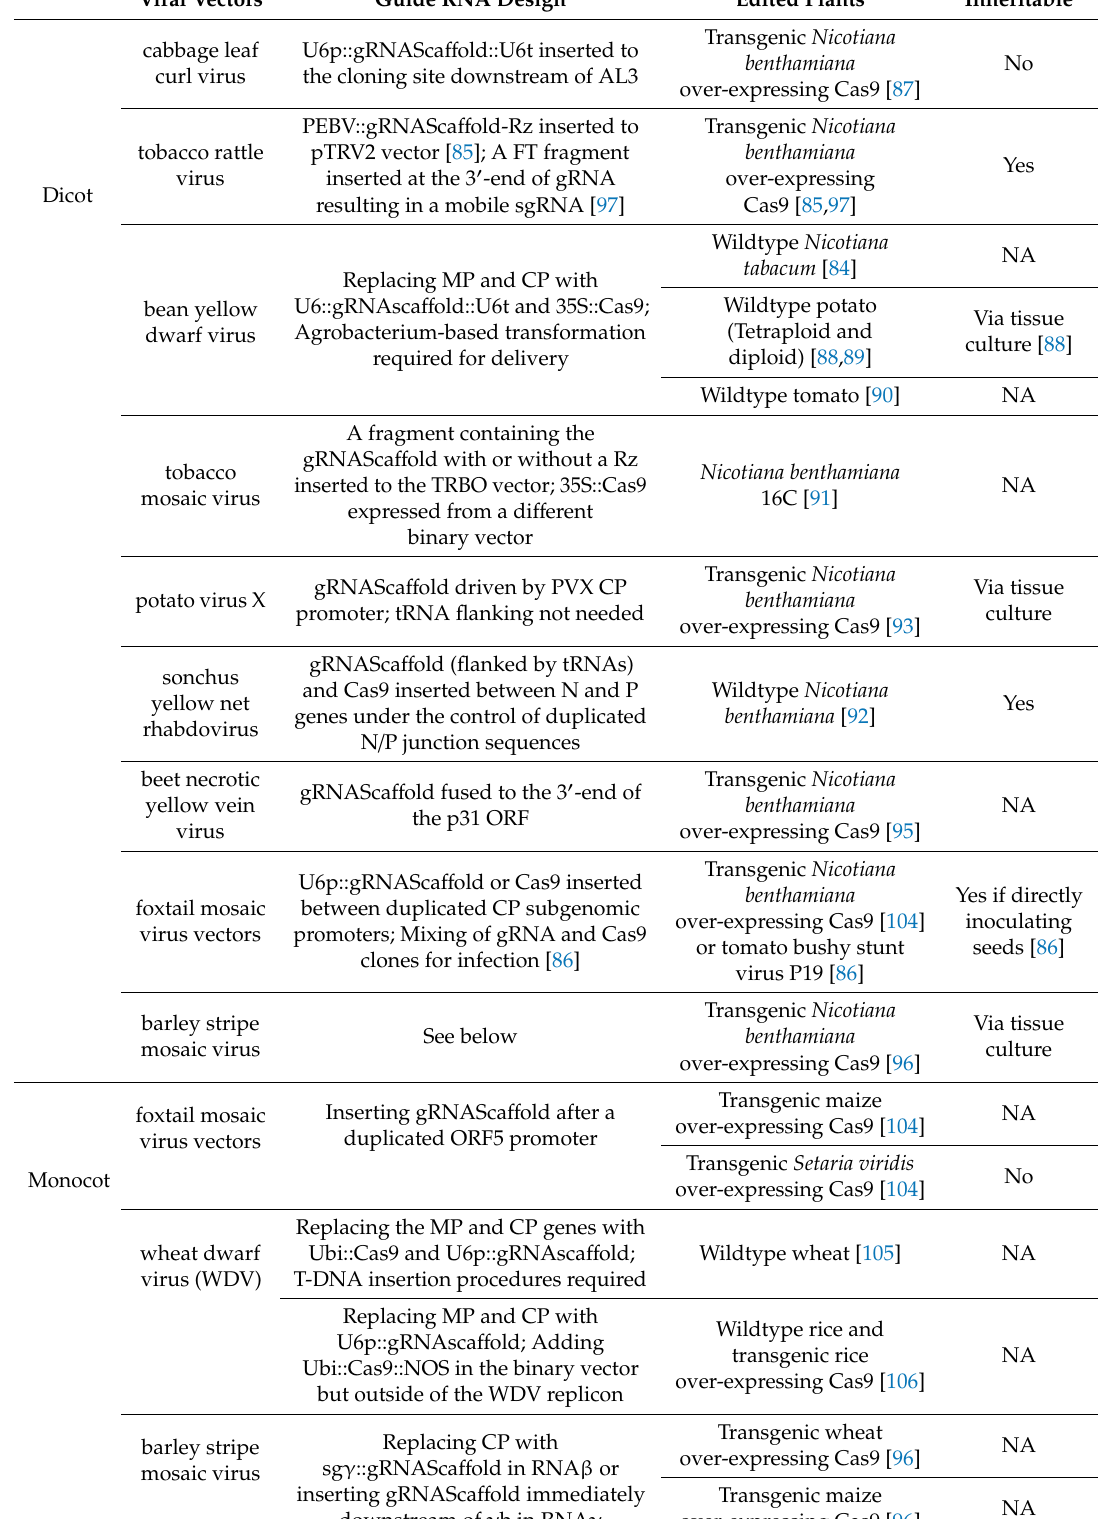
Table 3. Plant virus-induced genome editing